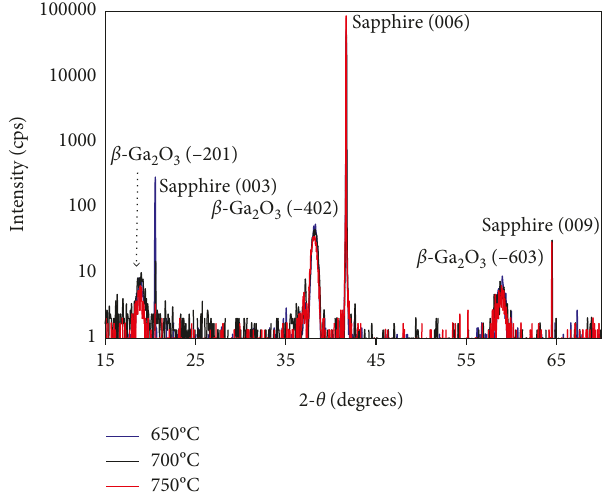
Figure 3: XRD spectra of β -Ga 2 O 3 films grown on sapphire at power of 300W and flux of